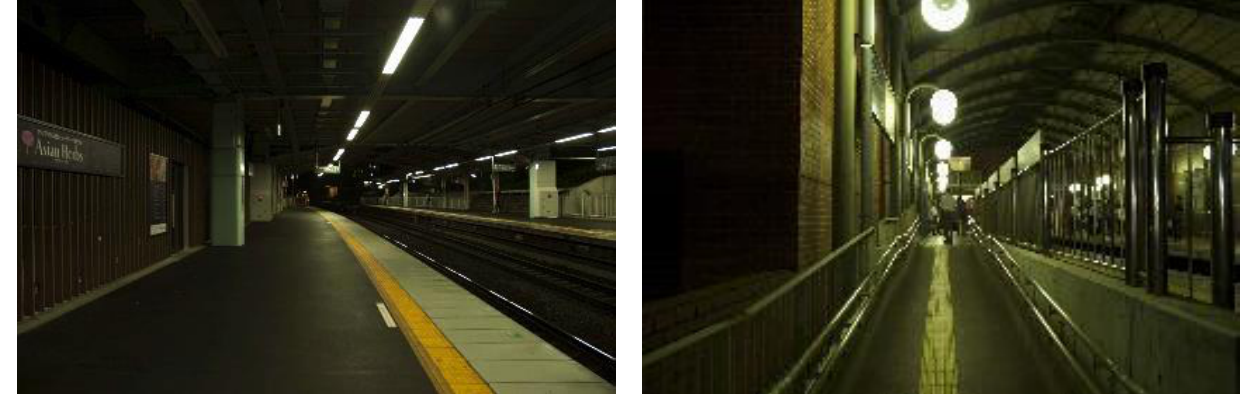
Figure 14. Font views of the No. 15 ( left ) and No. 25 ( right ) platforms.